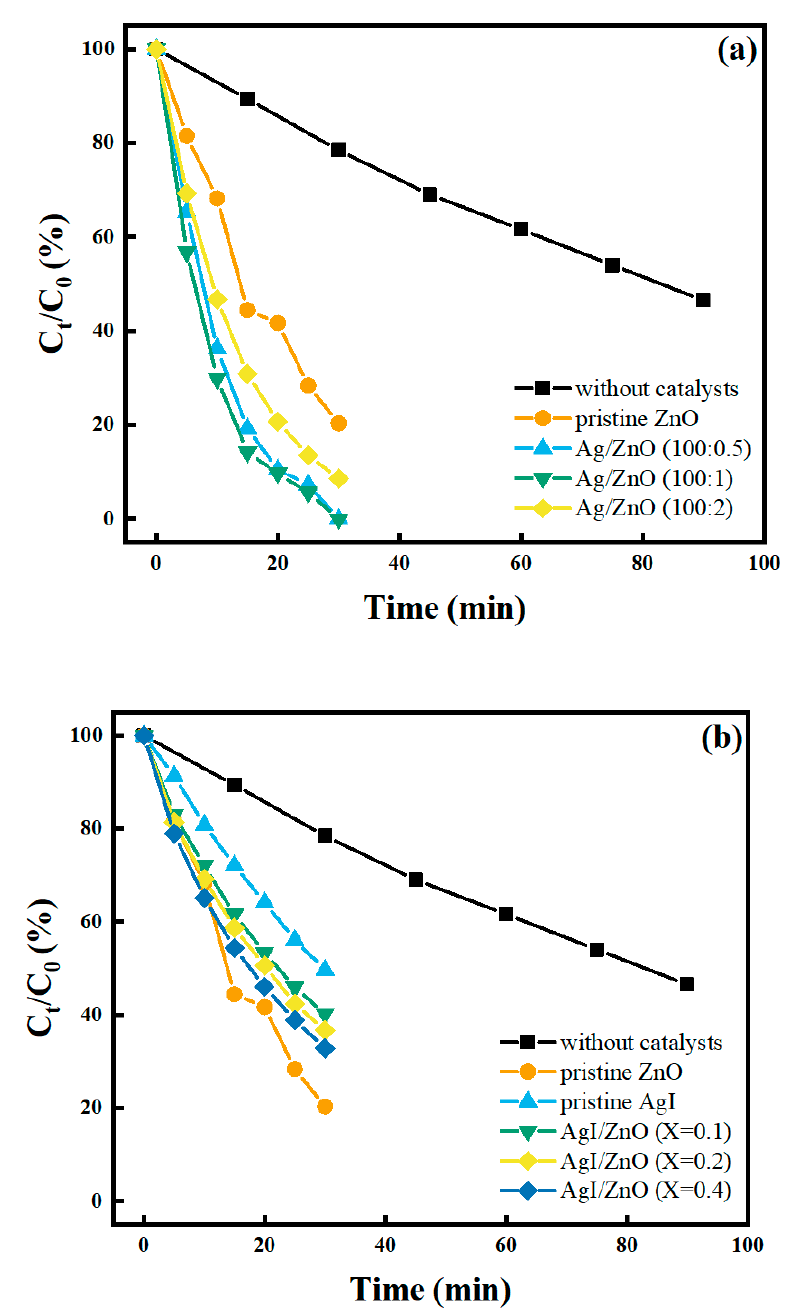
Figure 11. Photocatalytic degradation of MNZ under simulated sunlight with ( a ) Ag/ZnO, ( b ) of AgI/ZnO, of MNZ.